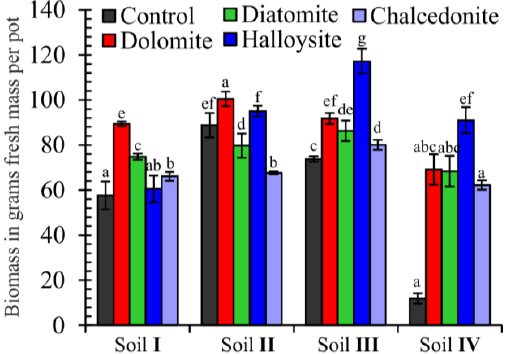
Figure 4. Effect of Cr contamination, and soil amendments on the above-ground biomass of Indian mustard in grams of fresh mass per pot. Error bars are ± standard error ( n = 3). Bars marked with different letters differ significantly for the same heavy metals exposure ( p < 0.05) according to the Duncan test.